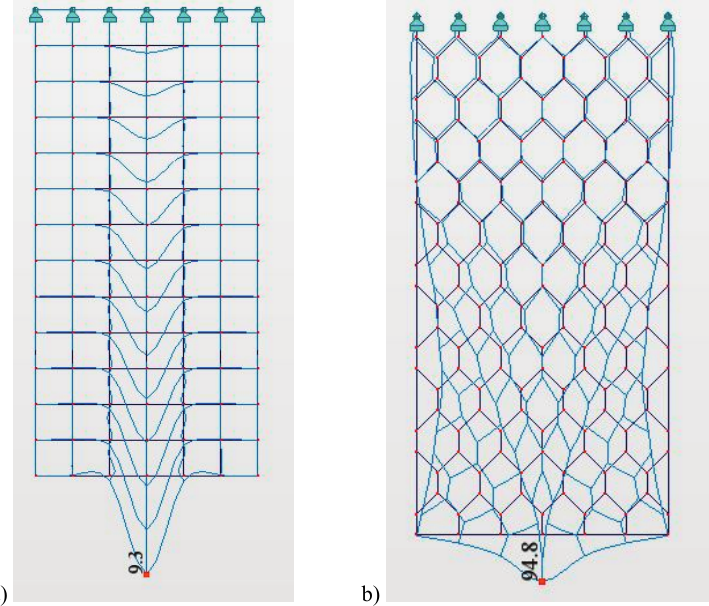
Fig. 8. Distortions while loading with the concentrated force of: a) welded mesh, b) woven